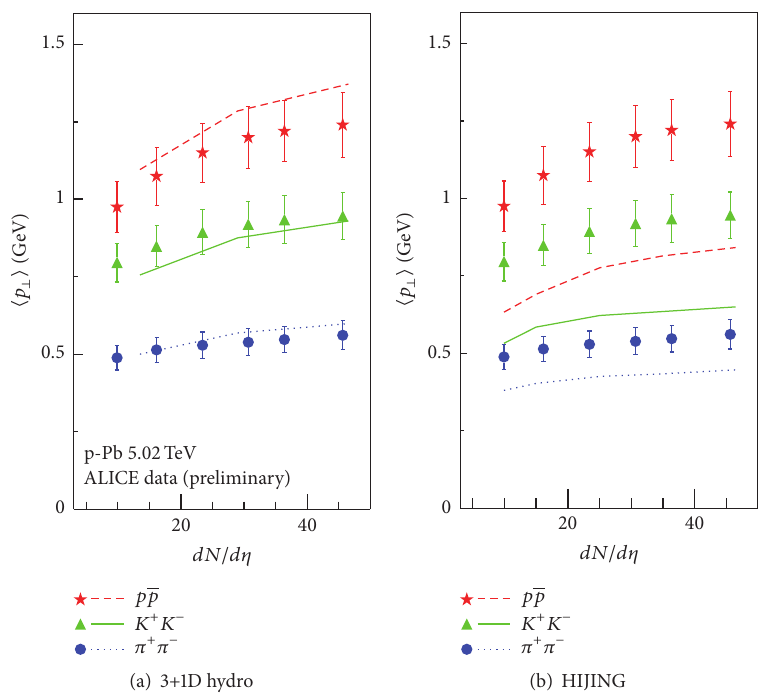
= 5.02 TeV;theexperimentaldata(varioussymbols) NN